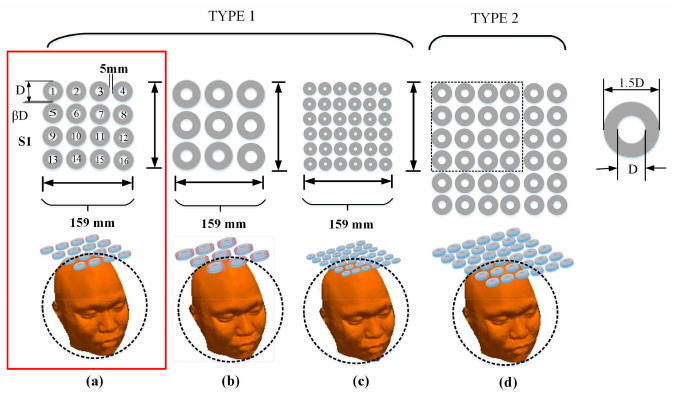
Figure 1. Segmentation method on the surface layer of top half of the head model. ( a – c ) Different orientations of